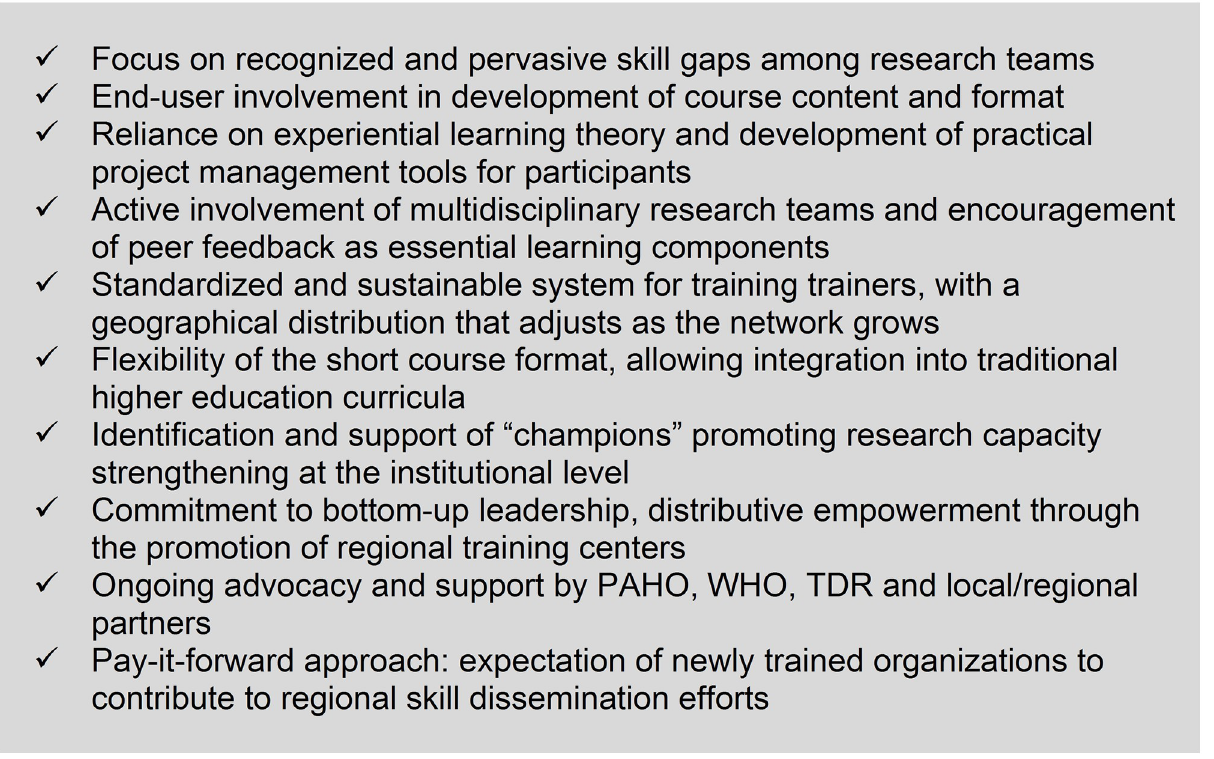
Fig 2. Keys to success of the “Planning for Success” initiative (identified by RTC and network institution trainers based on postcourse and program assessment). PAHO, Pan American Health Organization; RTC, Regional Training Center; TDR, XXX.